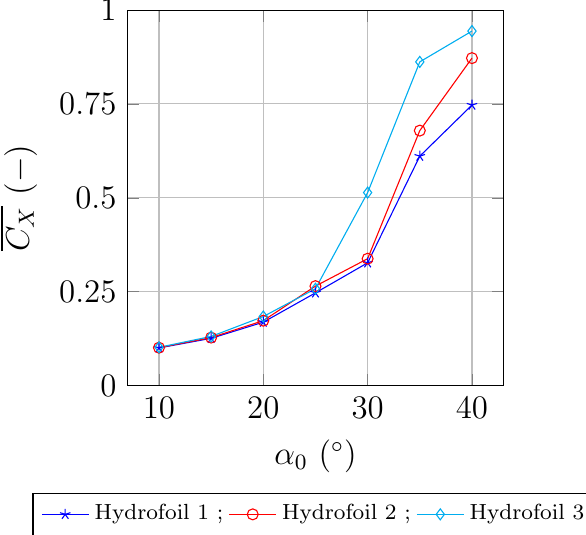
Figure 9. Mean hydrodynamic coefficient C X versus pitching amplitude α 0 for f ∗ = 0.025, ∆ h = 0.8 m, and for the three